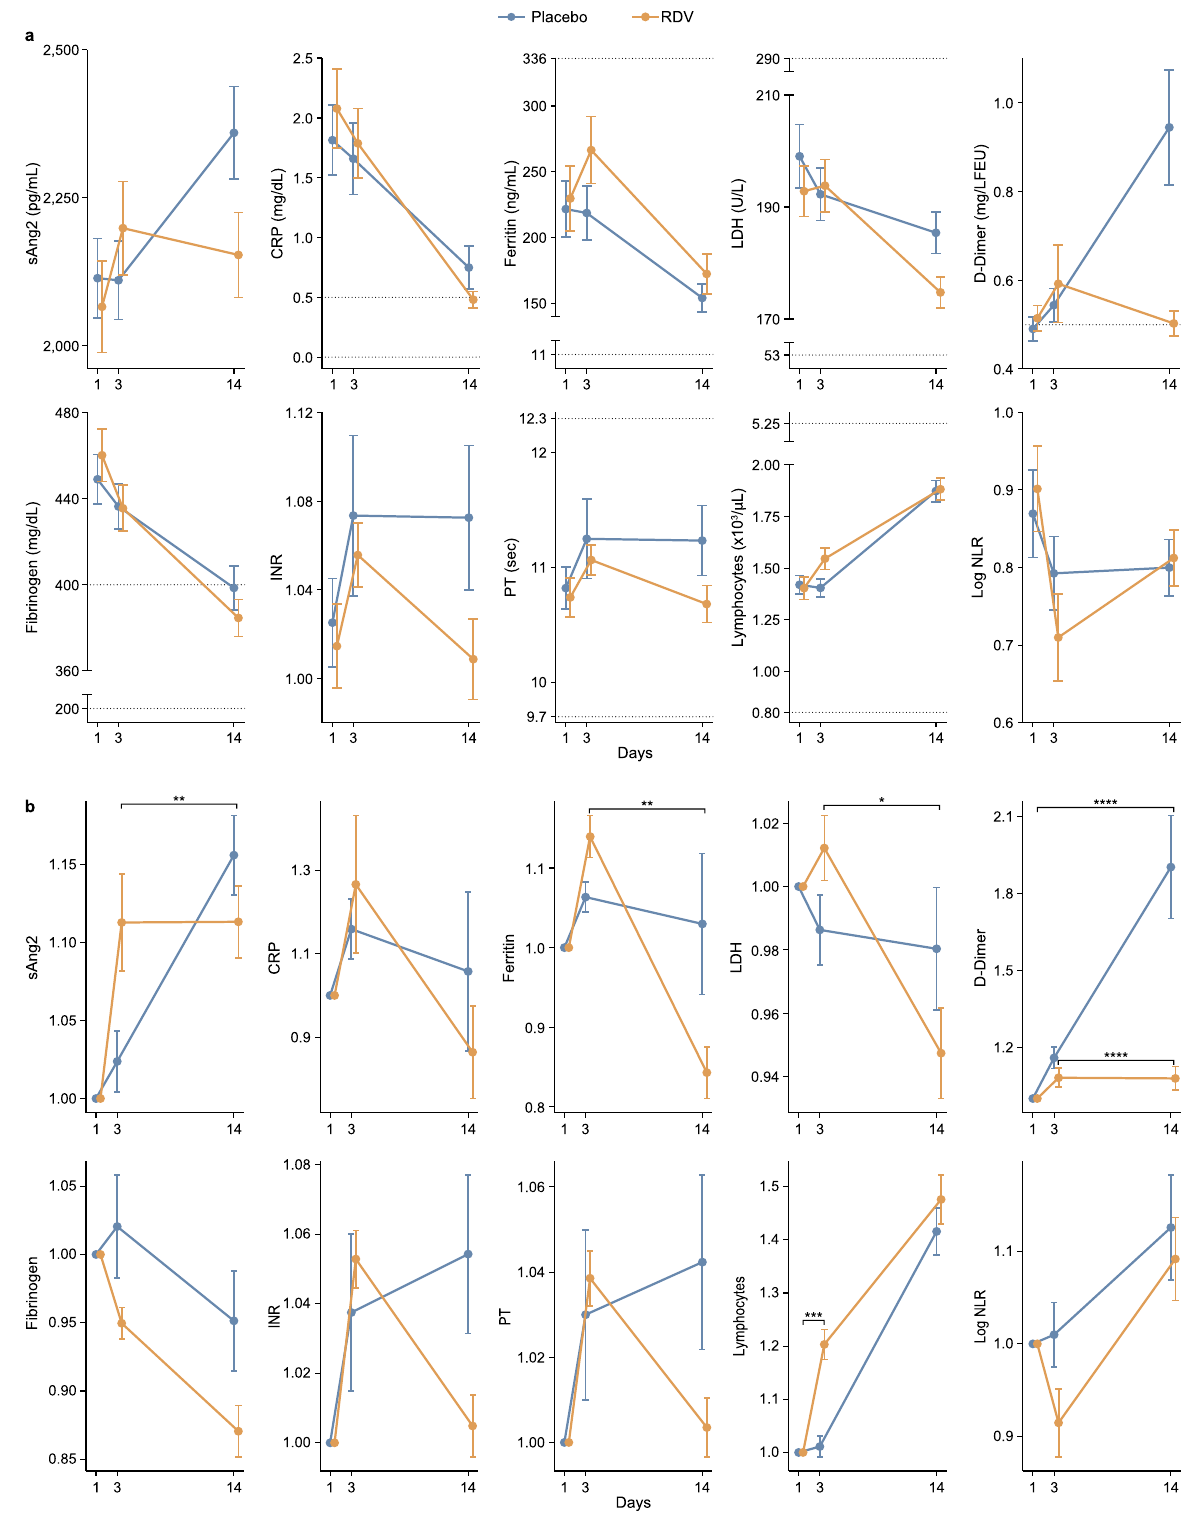
Fig. 2 Longitudinal changes in in fl ammation, coagulation, and hematologic biomarkers in remdesivir- vs. placebo-treated patients. Linear mixed effects model (LMM) used to test differences between day 3 and baseline (day 1), day 14 and day 3, and day 14 and baseline between remdesivir (RDV)- and placebo-treated patients. a Longitudinal plots of biomarker absolute value changes (mean with standard error) in RDV- (yellow) vs. placebo-treated (blue) patients. Dashed lines indicate normal ranges or expected values in healthy individuals. b Longitudinal plots of fold change (mean with standard error) in biomarkers in RDV- (yellow) vs placebo-treated (blue) patients. *FDR < 0.05, **FDR < 0.01, ***FDR < 0.001, ****FDR < 0.0001. Signi fi cance is determined by the LMM. The number of patients used in the LMM for each biomarker is provided Supplementary Data